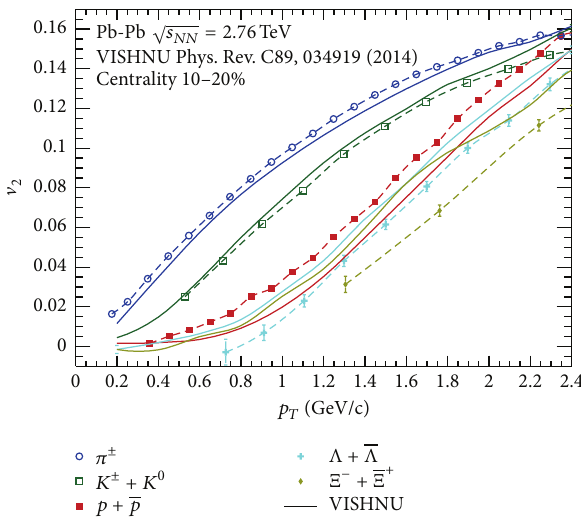
Figure 8: The comparison of ALICE measurements and VISHNU model calculations of V 2 as a function of 𝑝 𝑇 at √𝑠 𝑁𝑁 = 2.76 TeV for 10–20% central collisions [21, 25, 37, 38,